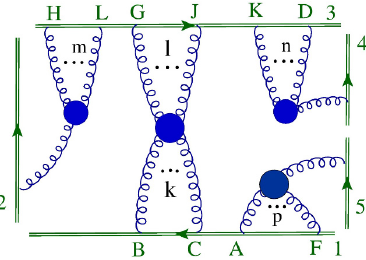
(1 , 1 , 1 , k + p, m + l + n ) 5